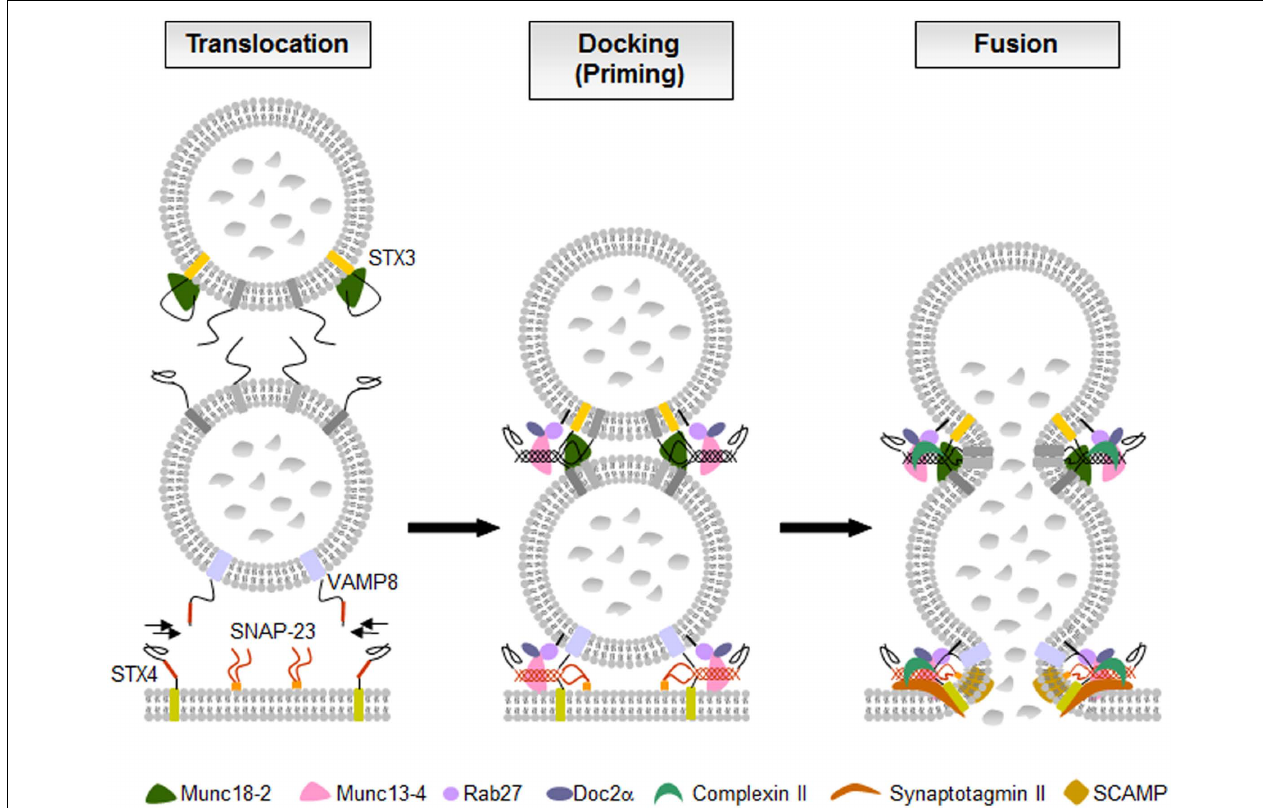
Munc13-4, Rab27, Doc2 α , complexin II, synaptotagmin II, or SCAMPs, are involved as “gatekeepers” of the fusion reaction holding effectors in an inactive state, as tethering factors controlling docking and priming, or as regulators of the SNARE complexes triggering the calcium-dependent membrane